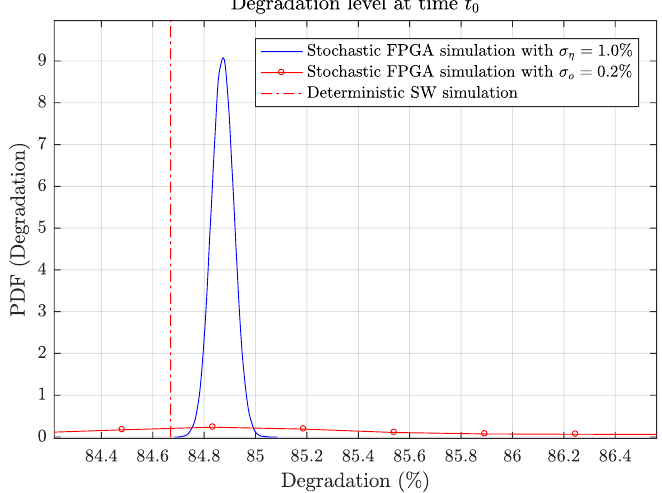
Figure 21. Degradation state PDF at the beginning of the prognostics stage t = t 0